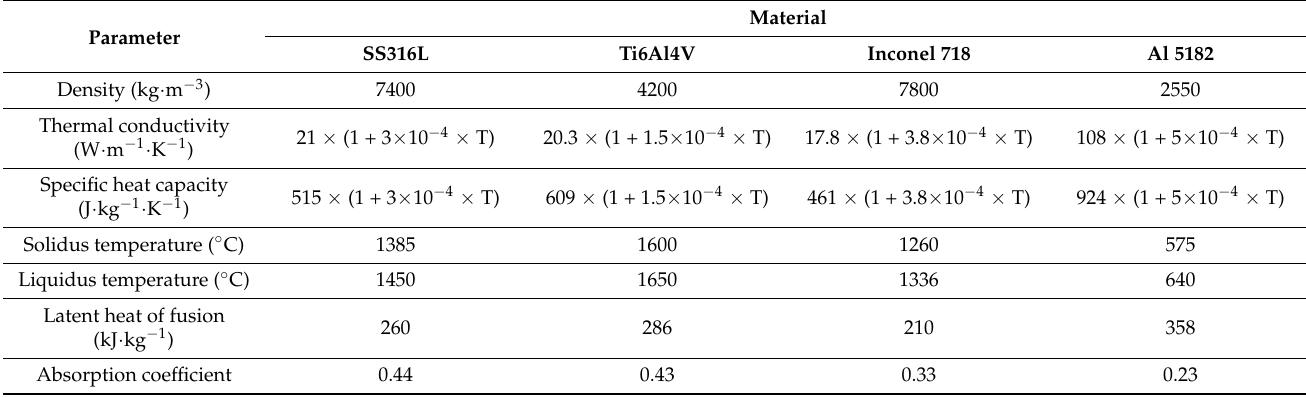
Table 1. Material properties for SS316L, Ti6Al4V, Inconel 718, Al 5182